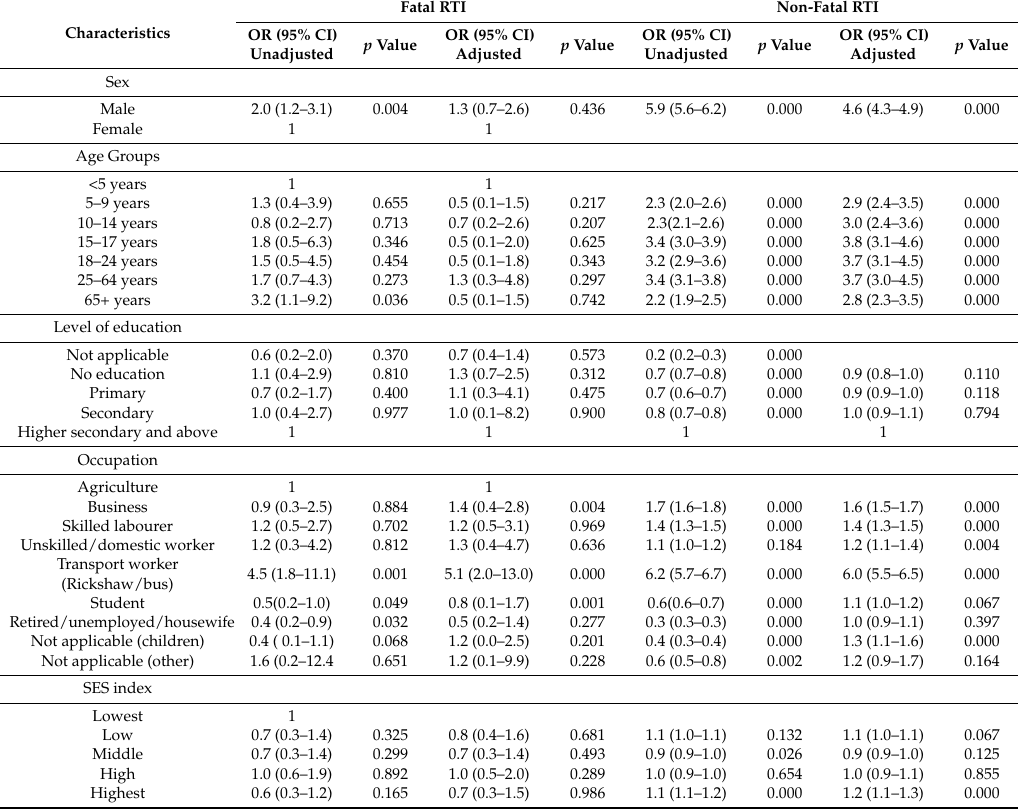
Table 4. Association between sociodemographic factors and fatal and non-fatal